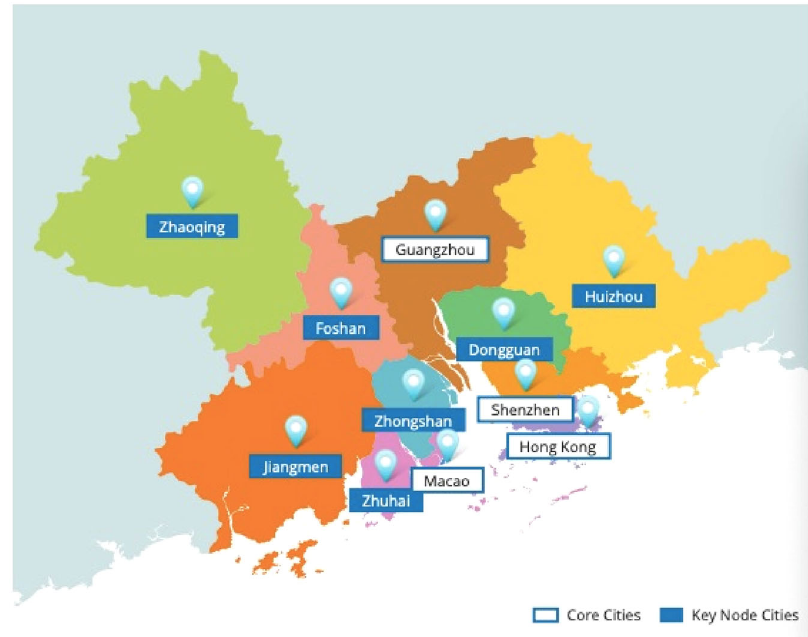
Fig. 1 Cities in the GBA. Map based on Gov HK